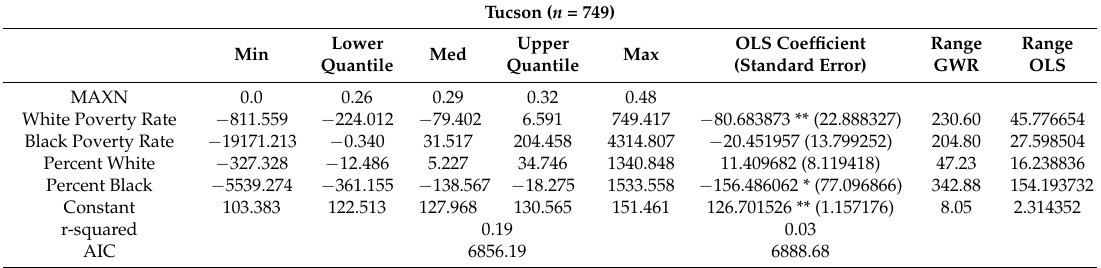
Table 10. Global and Local Parameter Estimates of the Geographically Weighted Regression Model for Tucson.